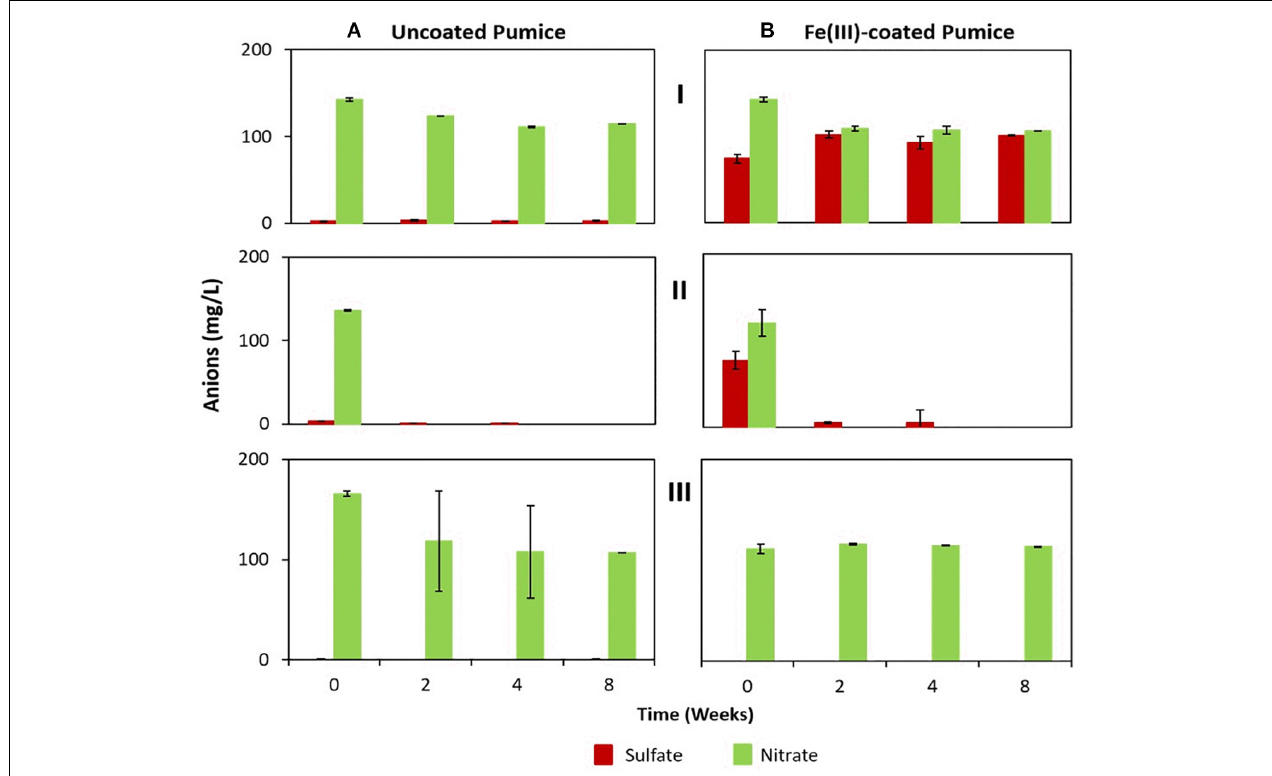
FIGURE 5 | Sulfate and nitrate concentrations in the deployed uncoated/Fe(III)-coated pumice slurries incubated for 8 weeks at 20 ◦ C. (I) Deployed pumice unamended with electron donors. (II) Deployed pumice amended with lactate and acetate. (III) Non-deployed pumice unamended with electron donors (Control). Data are the means ± standard errors of triplicates. (A) Uncoated pumice treatment. (B) Fe(III)-coated pumice treatment.